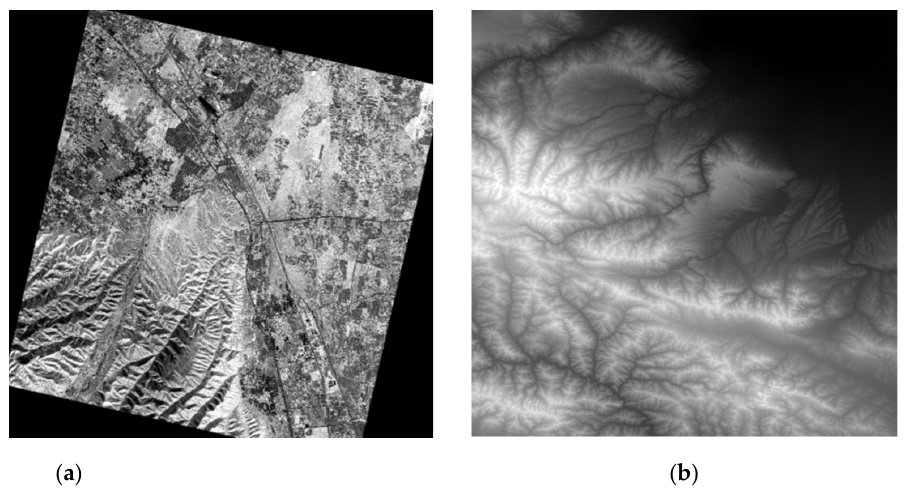
Figure 5. Original DOM and DEM used in simulation: ( a ) SuperView-1 panchromatic image; ( b ) ASTER DEM.